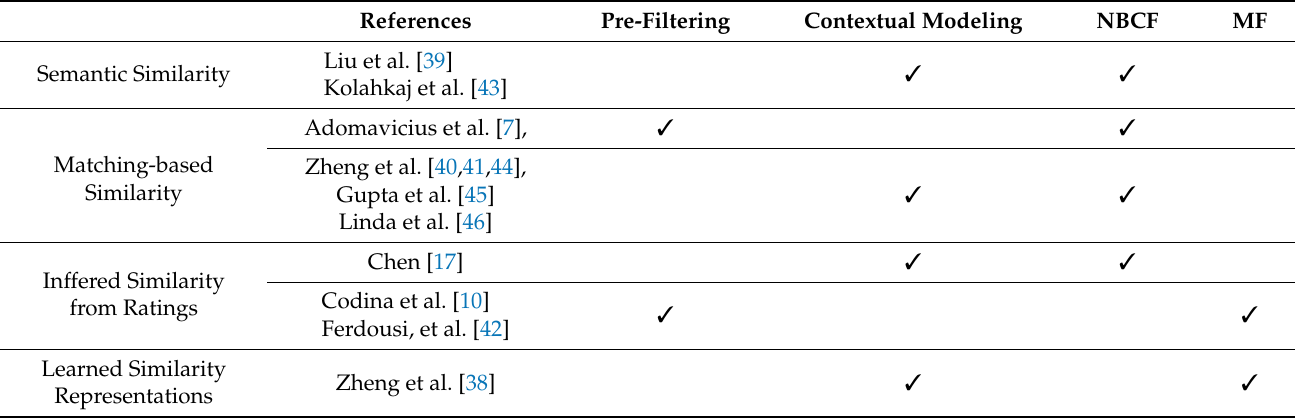
Table 1. Summary of Context Similarity Approaches.